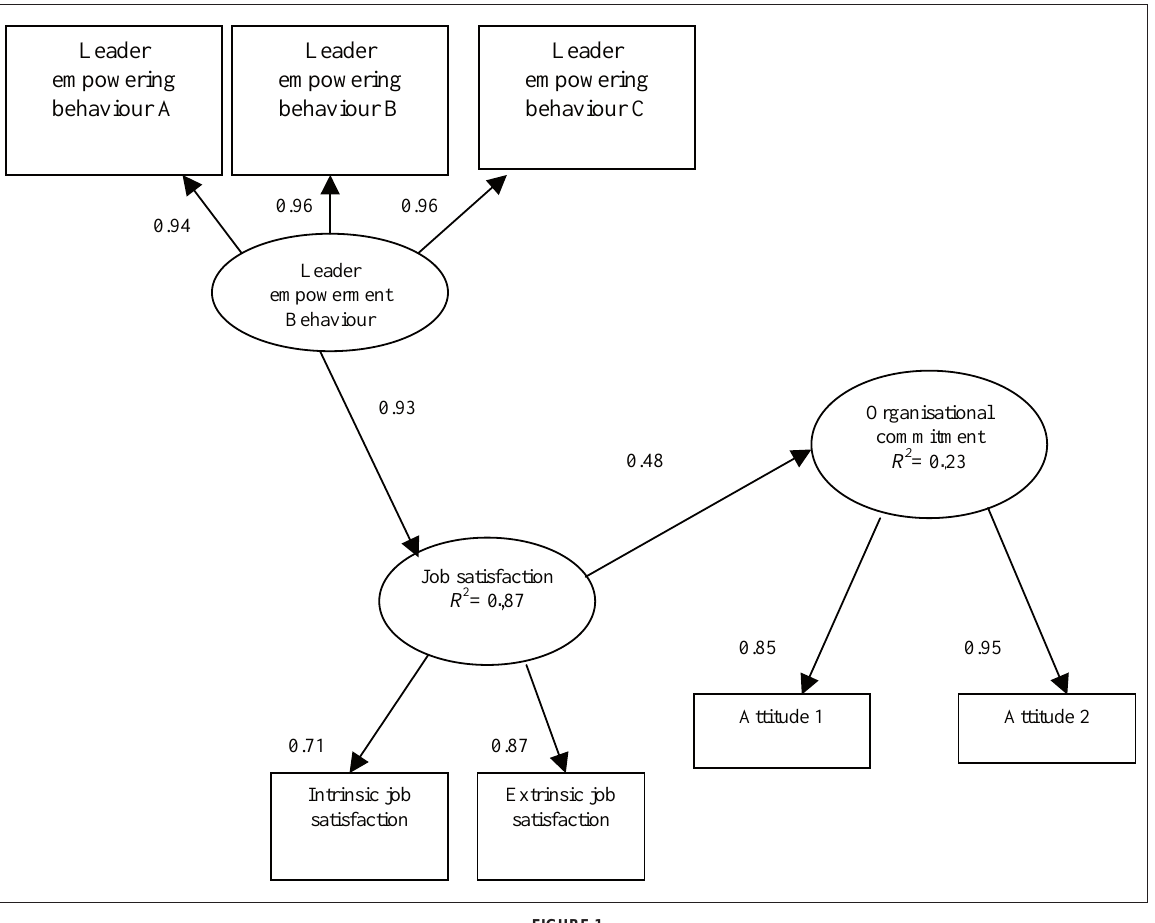
FIgurE 1 The structural model of leader empowering behaviour, job satisfaction and organisational